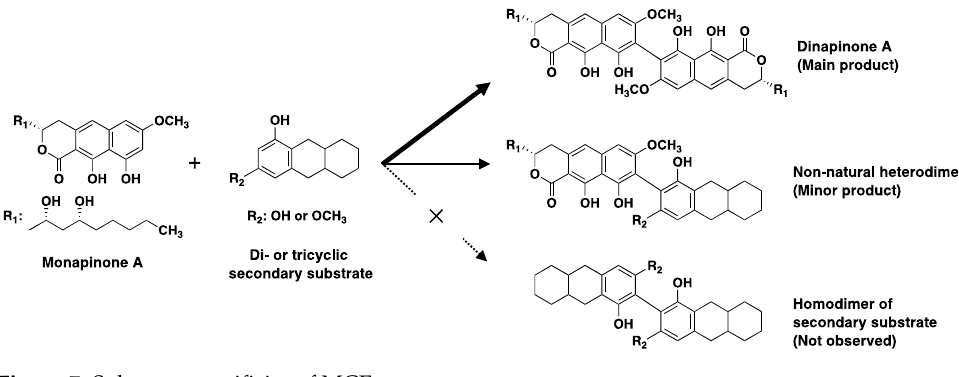
Figure 7. Substrate specificity of MCE.